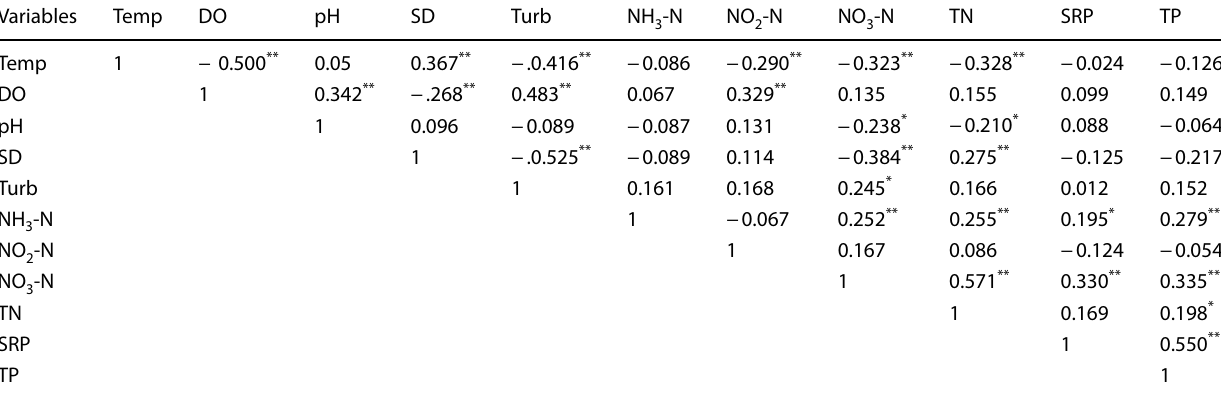
Table 7 Pearson correlation matrix for physicochemical water quality variables (n = 108)